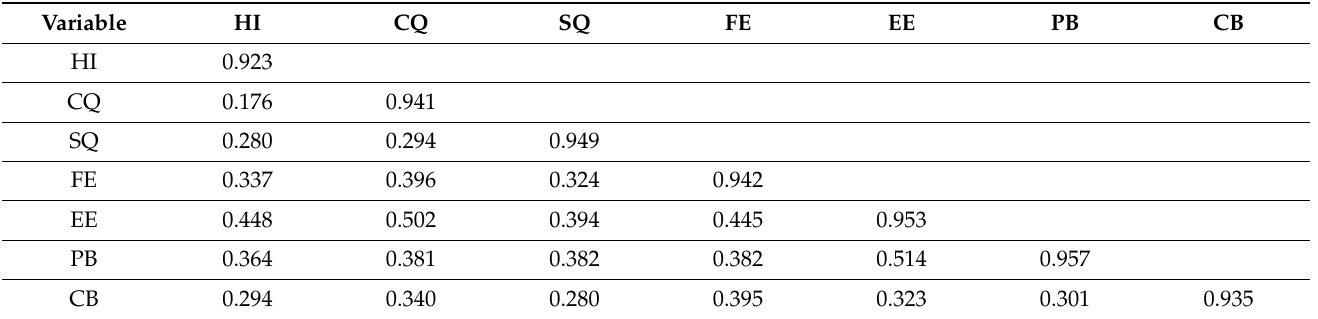
Table 4. Discriminant validity.